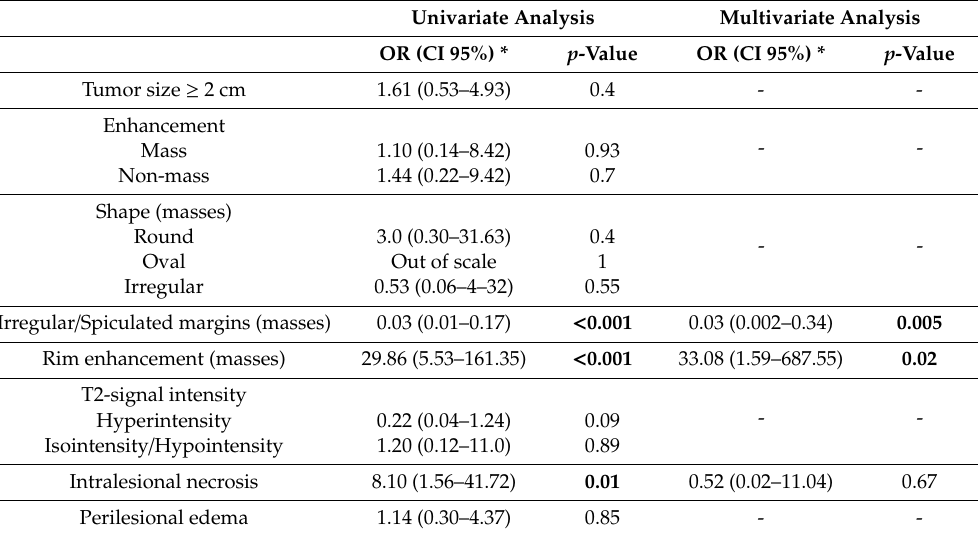
* OR = Odds Ratio; CI = Confidence Interval.